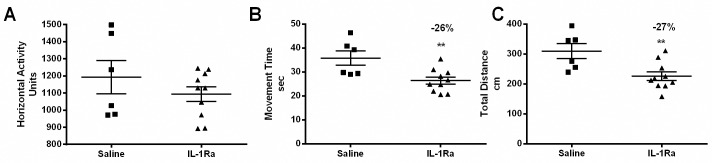
IL-1Ra treatment decreases activity and increases rest time in mdx mice.Horizontal activity (A) was measured using an open-field Digiscan apparatus and did not differ significantly between IL-1Ra- and saline-treated mice. During the Digiscan measurements, the (B) movement time (26% decrease in the IL-1Ra-treated mice vs. control, p = 0.0075) and (C) total distance traveled (27% decrease in the IL-1Ra-treated mice vs. control, p = 0.008) were recorded and were significantly lower in the IL-1Ra-treated mice than in the controls. Graphs represent mean ± SEM and statistically significant differences were determined by parametric, unpaired, two- tailed, t-tests with a p≤0.05 being significant. (n = 6 saline, n = 10 IL-1Ra).